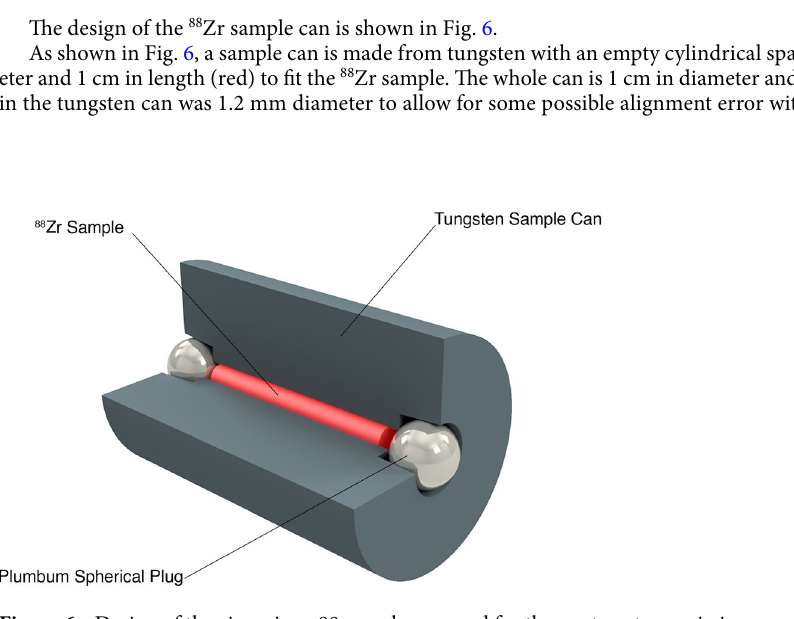
Figure 6. Design of the zirconium-88 sample can used for the neutron transmission measurements at